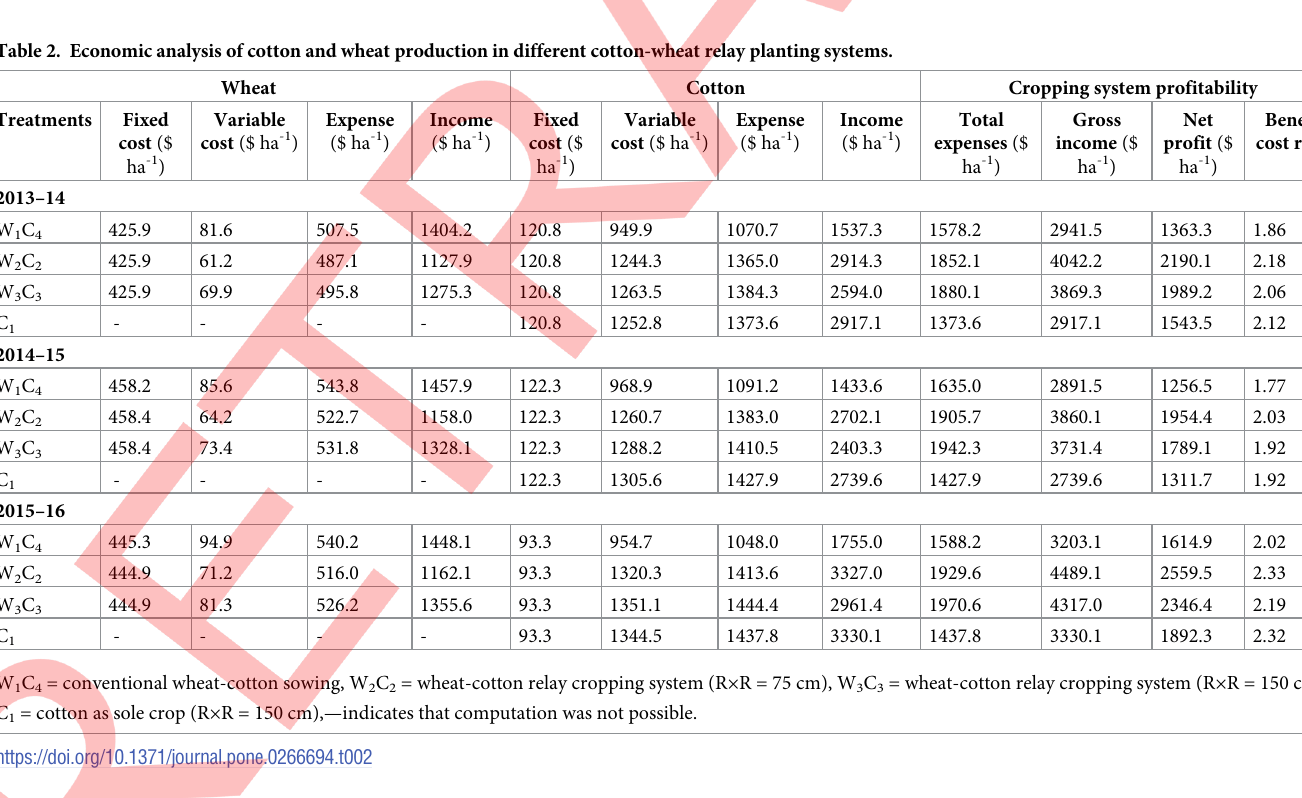
Table 2. Economic analysis of cotton and wheat production in different cotton-wheat relay planting systems. Wheat